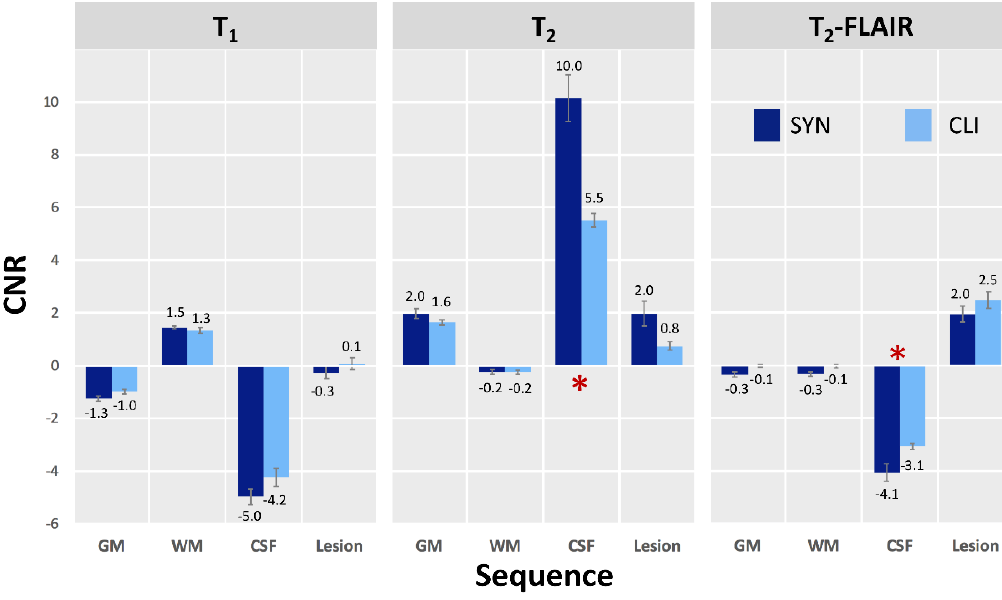
Figure 5. The standardized contrast-to-noise ratio (CNR) in synthetic and clinical scans of four brain regions. Significant differences were found between synthetic and clinical T 2 -weighted and T 2 -FLAIR images of cerebrospinal fluid regions (* Bonferroni corrected p < 0.05).